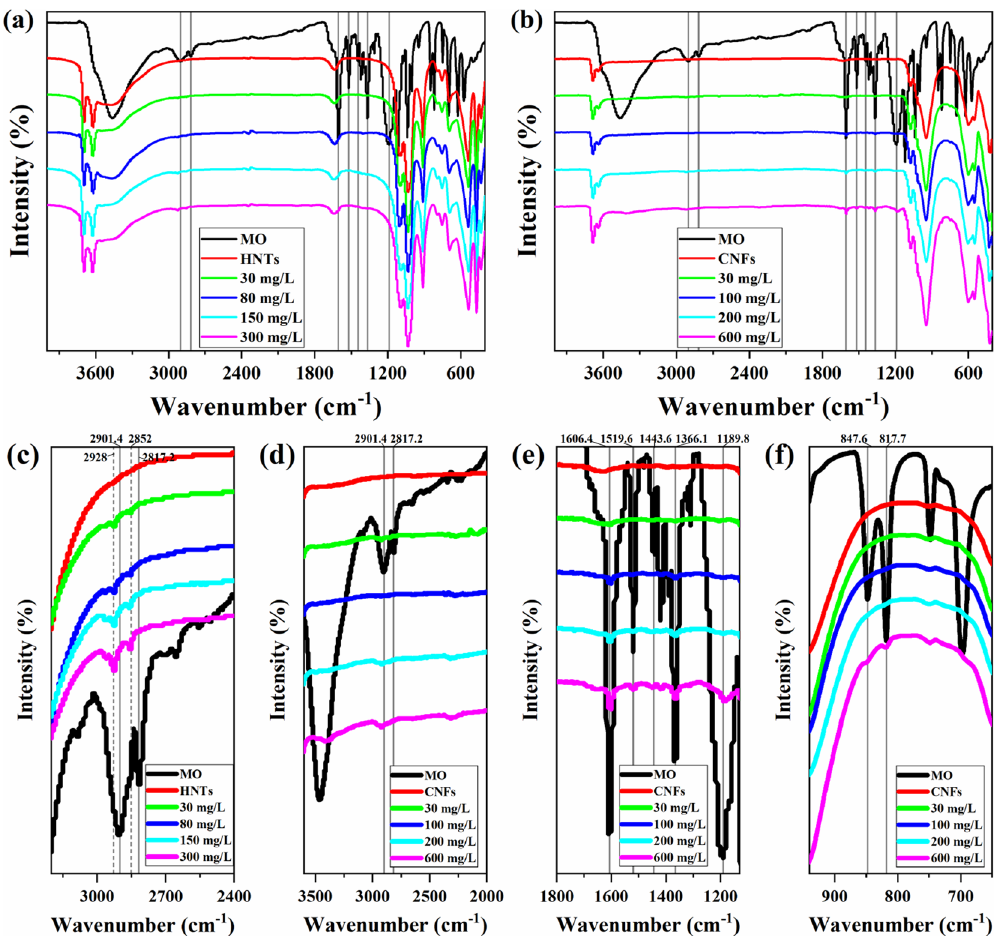
Figure 6. FTIR of HNTs ( a,c ) and ChNTs ( b,d,e,f ) at different initial